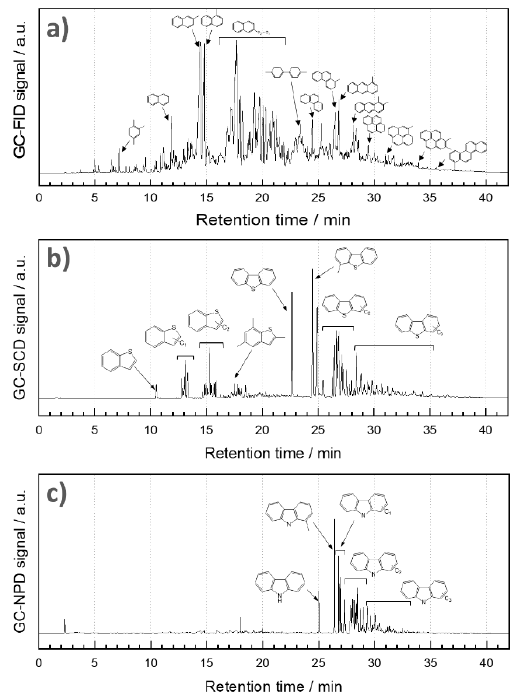
Figure 1. GC chromatograms of light cycle oil: ( a ) aromatic compounds, ( b ) sulfur compounds, and ( c ) nitrogen